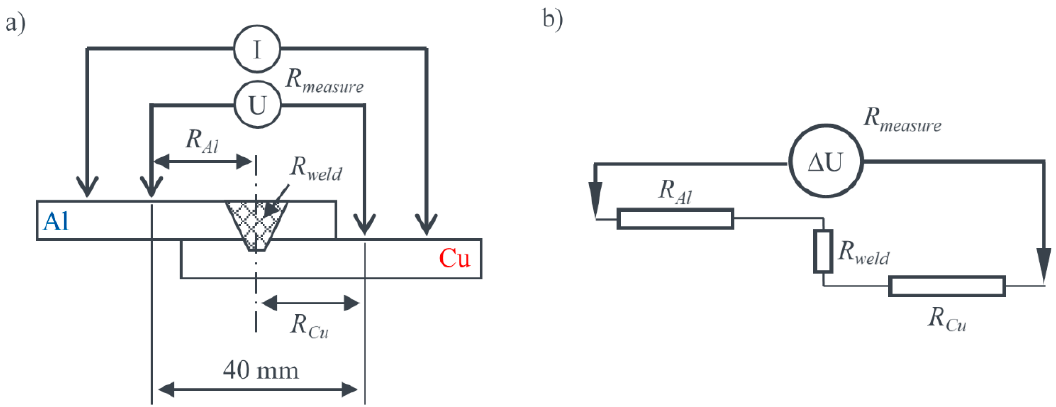
Figure 3. ( a ) Sketch of the four-point measurement setup used to determine the electrical resistance of the joints; ( b ) equivalent circuit for the measured resistance.